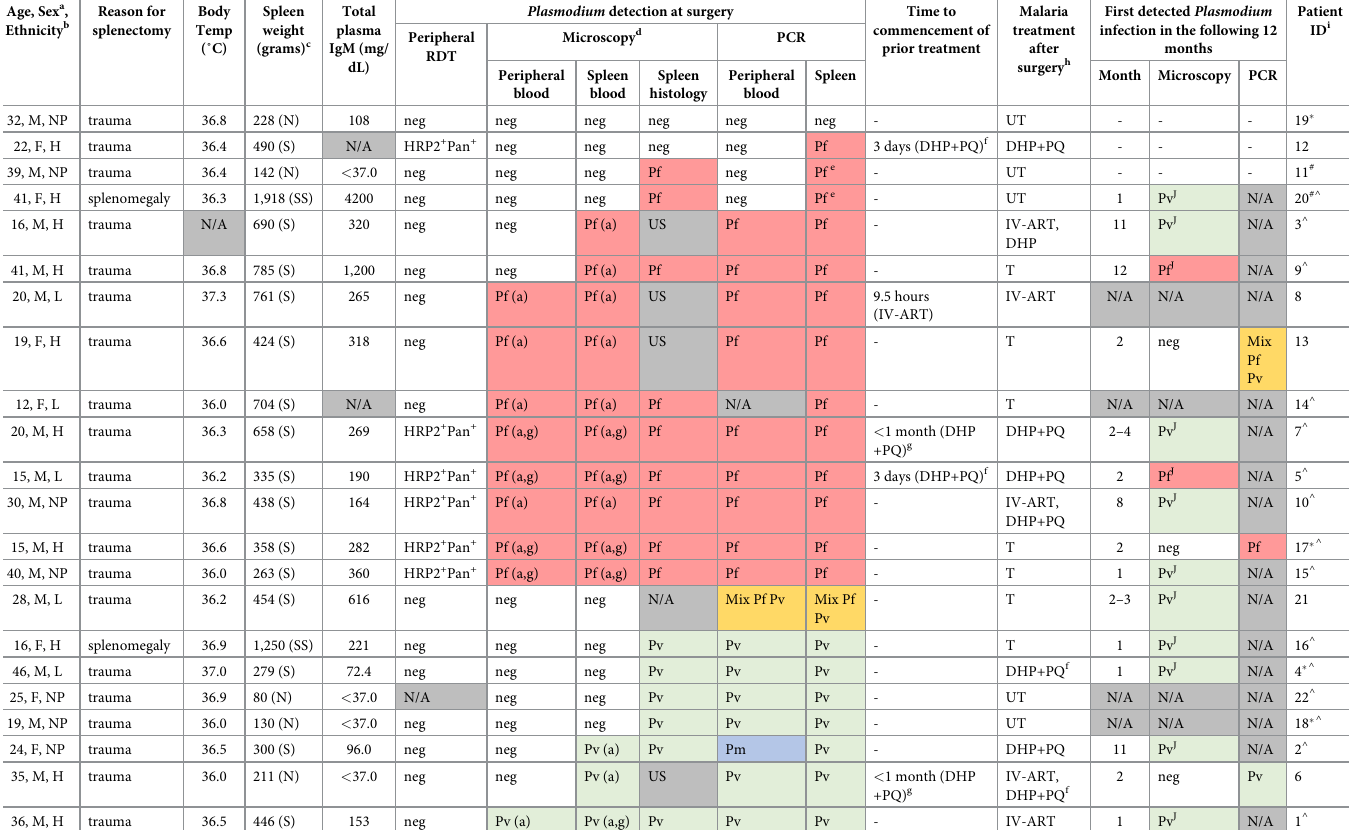
Table 1. Patient records and Plasmodium detection. Age,Sex a , Reasonfor Ethnicity b